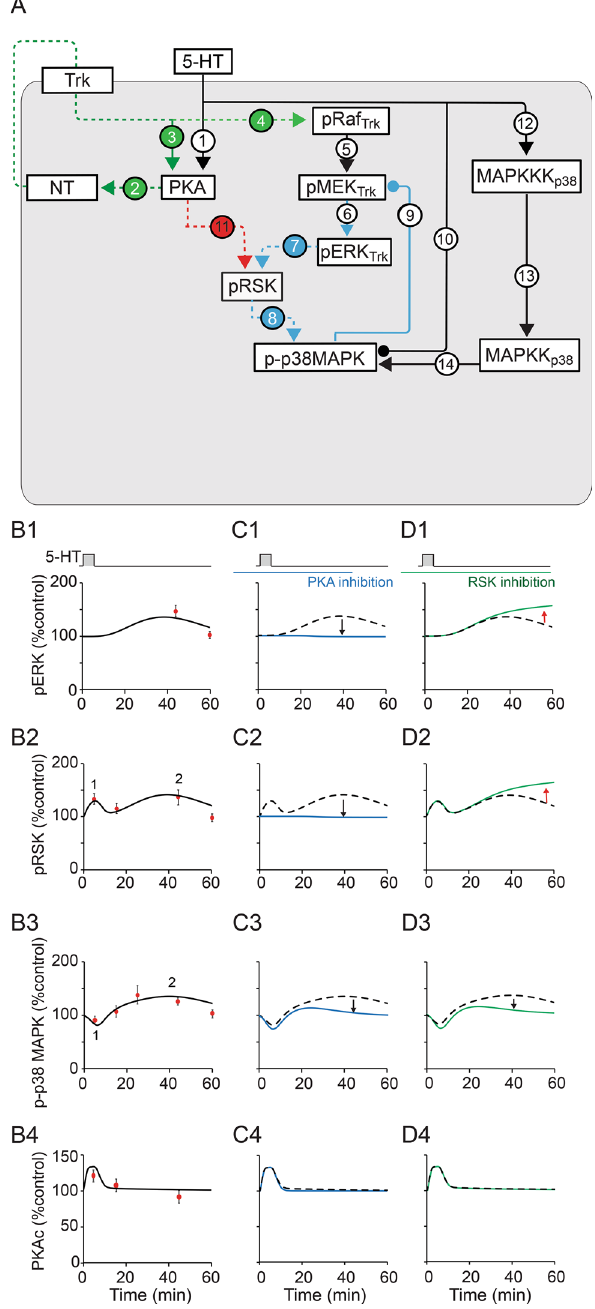
Figure 3. ( A ) Schematic model of PKA and MAPK signaling pathways. 5-HT regulates the PKA and MAPK cascades via multiple pathways. Red, blue, green dashed lines represent newly added pathways. Blue denotes the ERK/RSK/p38 MAPK feedback loop, green denotes the NT-dependent pathways. Each number represents a signaling pathway (not equation numbers). Arrowheads indicate activation, circular ends indicate repression. ( B – D ) Simulated dynamics of kinases after one pulse of 5-HT. ( B ) Control simulations (black solid curves). Empirical data points (red circles) are from this study (PKAc and pRSK) and from Zhang et al. 11 (pERK and p-p38 MAPK). Numbers “1”, “2” in B2 represent two waves of increases in pRSK. The “1” in B3 represents the transient decrease of p-p38 MAPK. The “2” in B3 represents the delayed increase of p-p38 MAPK. ( C ) Dynamics of kinases with a simulated inhibition of downstream effects of PKA, ended 45 min post-onset of 5-HT. The slow increases of pERK (C1), pRSK (C2) and p-p38 MAPK (C3) were blocked. Blue curves are simulations with inhibitors, black dashed curves are control simulation. This inhibition suppressed the delayed activation of pERK as observed empirically in Fig. 2A, and pRSK and p-p38 MAPK subsequently decreased (black arrows). Control simulation curves added in this and following panels and figures, are for the convenience of comparison with the curves in the presence of inhibitors. Dashed curves are used to make overlapped curves visible. ( D ) Dynamics of kinases with simulated inhibition of RSK ending 60 min post-onset of 5-HT. The delayed increase of p-p38 MAPK (D3) was blocked by RSK inhibition, but pERK (D1) and pRSK (D2) remained elevated for 60 min. Green curves are simulations with inhibitors, black dashed curves are control simulation. This RSK inhibition suppressed the delayed activation of p-p38 MAPK (D3, black arrow) as observed empirically (Fig. 2F). Reduced p-p38 MAPK activity disinhibited MEK. The disinhibition led to a sustained increase of pERK and pRSK at 1 h (D1-2, red